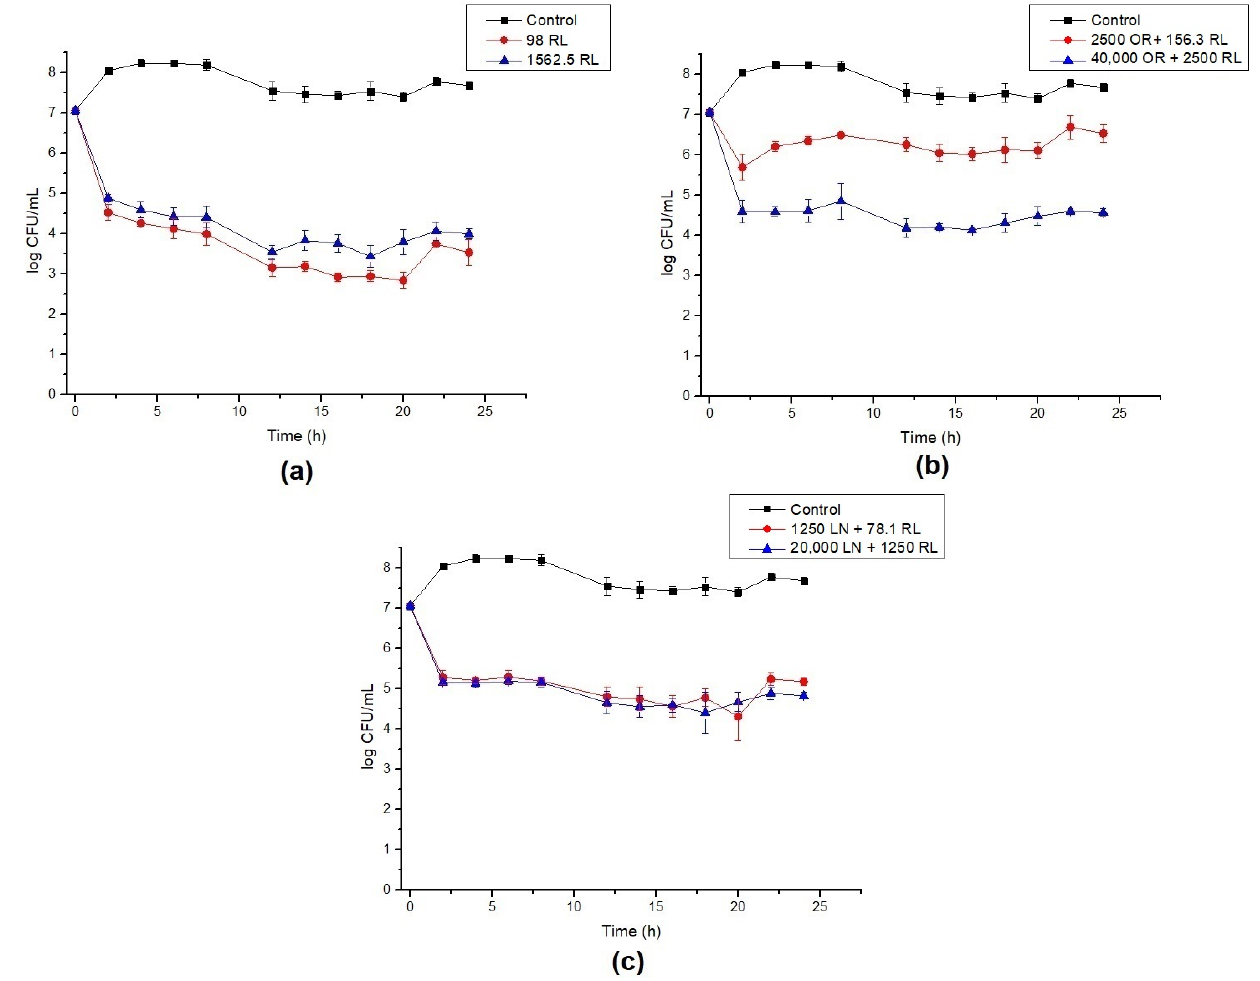
Figure 1. Time–kill curves for B. cereus with ( a ) rhamnolipid (RL), ( b ) celery oleoresin (OR) + RL, and ( c ) limonene (LN) + RL. Lines show the log CFU/mL for the control (black), minimum inhibitory concentration (MIC) (red), and 16× MIC (blue). Error bars show the standard deviation of at least three independent replicates.